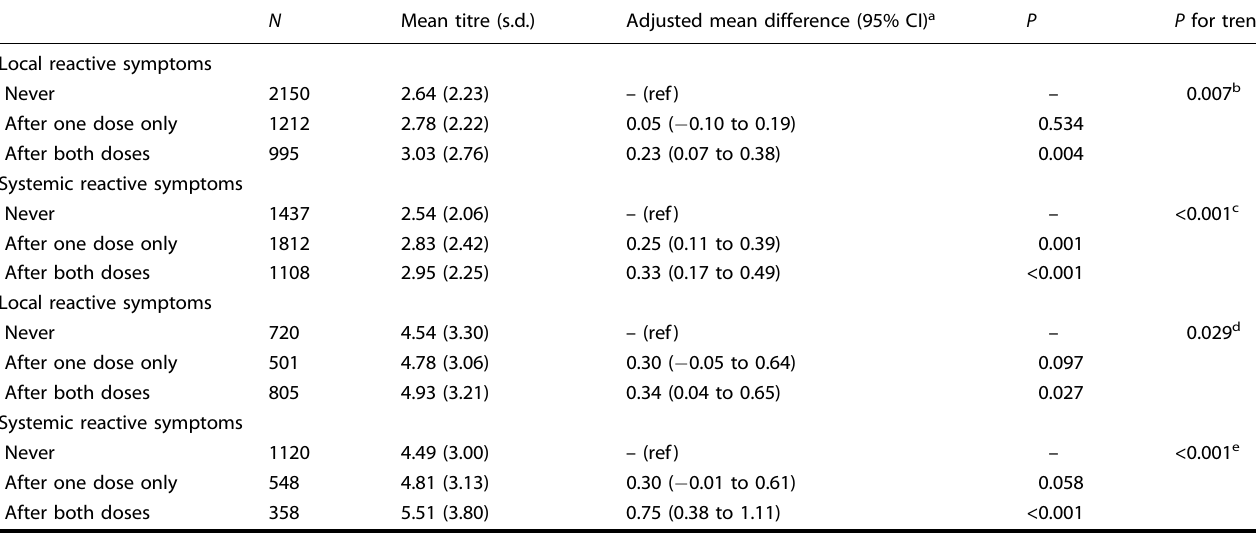
Table 4. Post-vaccination antibody titres by vaccine type and post-vaccination reactive symptoms. N Mean titre